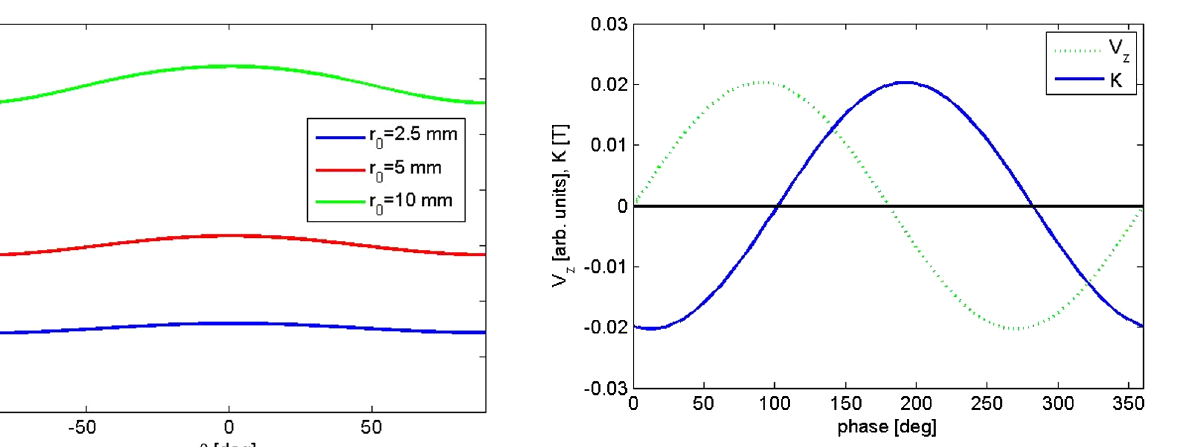
imaginary) calculated in the center of the full cell for three different circle radii ( r 0 ) and for one-half of the structure ( θ ¼ π = 2 is below the coupling